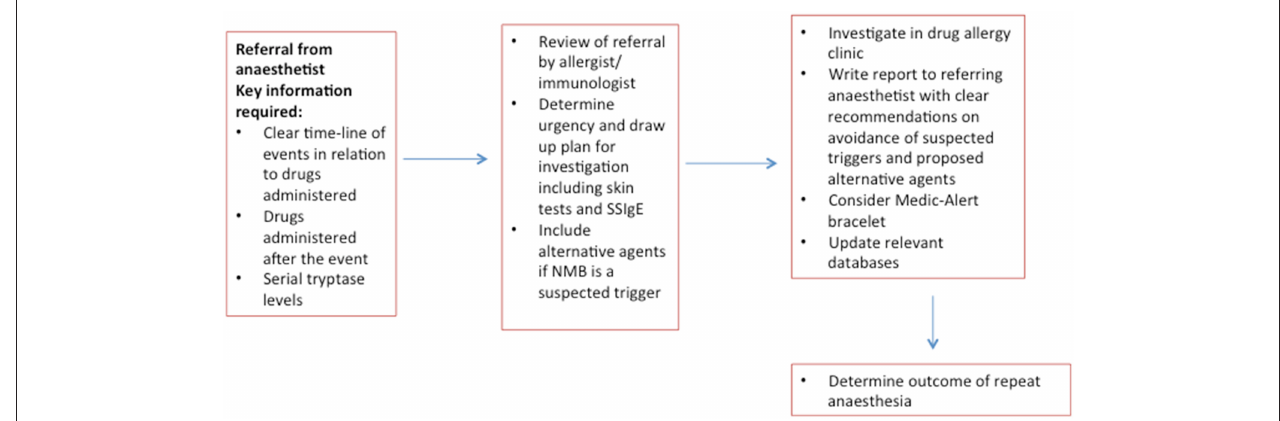
FIGURE 1 | Flow chart for investigation of peri-operative anaphylaxis.